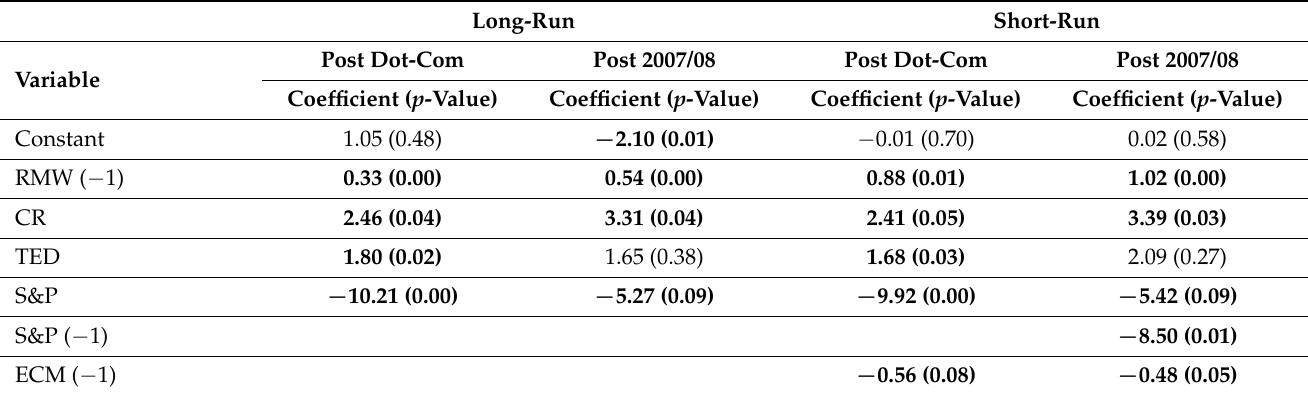
Table 23. Long-run ARDL model and short-run error correction model for RMW (Non-Recession).